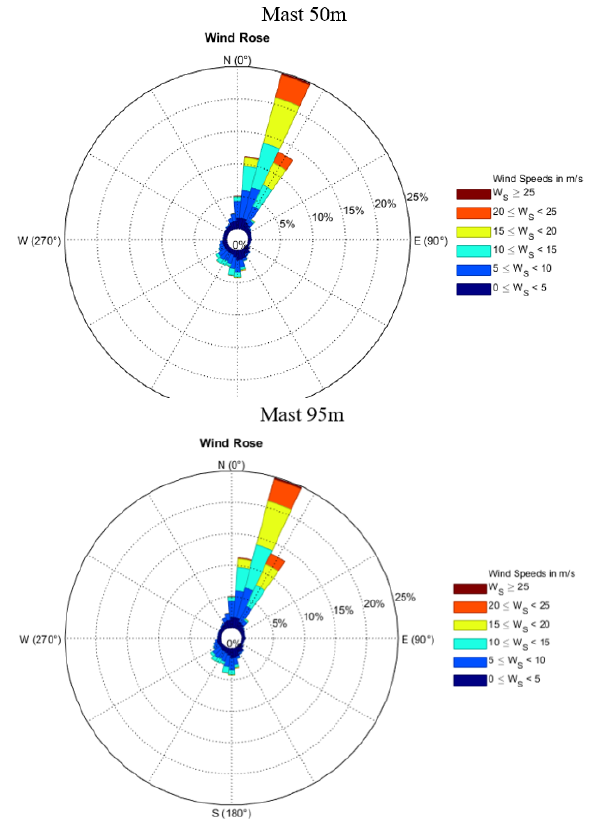
Figure 5. Wind rose from 1 April 2016 to 1 April 2017 at mast heights of 50 m and 95 m.